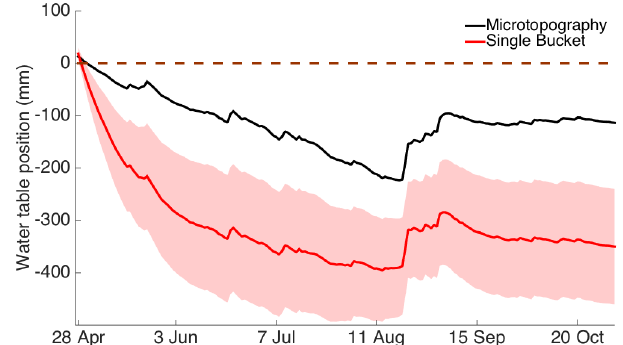
Figure 3. Ensemble simulations of water table dynamics. The Mi- crotopography version of the HH model (black line) is compared to the Single Bucket version (red line). The water table in the Mi- crotopography version is averaged over the whole model region. The micro-topography affects water table position by delaying the runoff, because of the complex interactions among the grid cells, as resolved in a finer scale model. The shaded areas represent the standard deviation over 30 simulations (but their small size renders them invisible in the microtopography